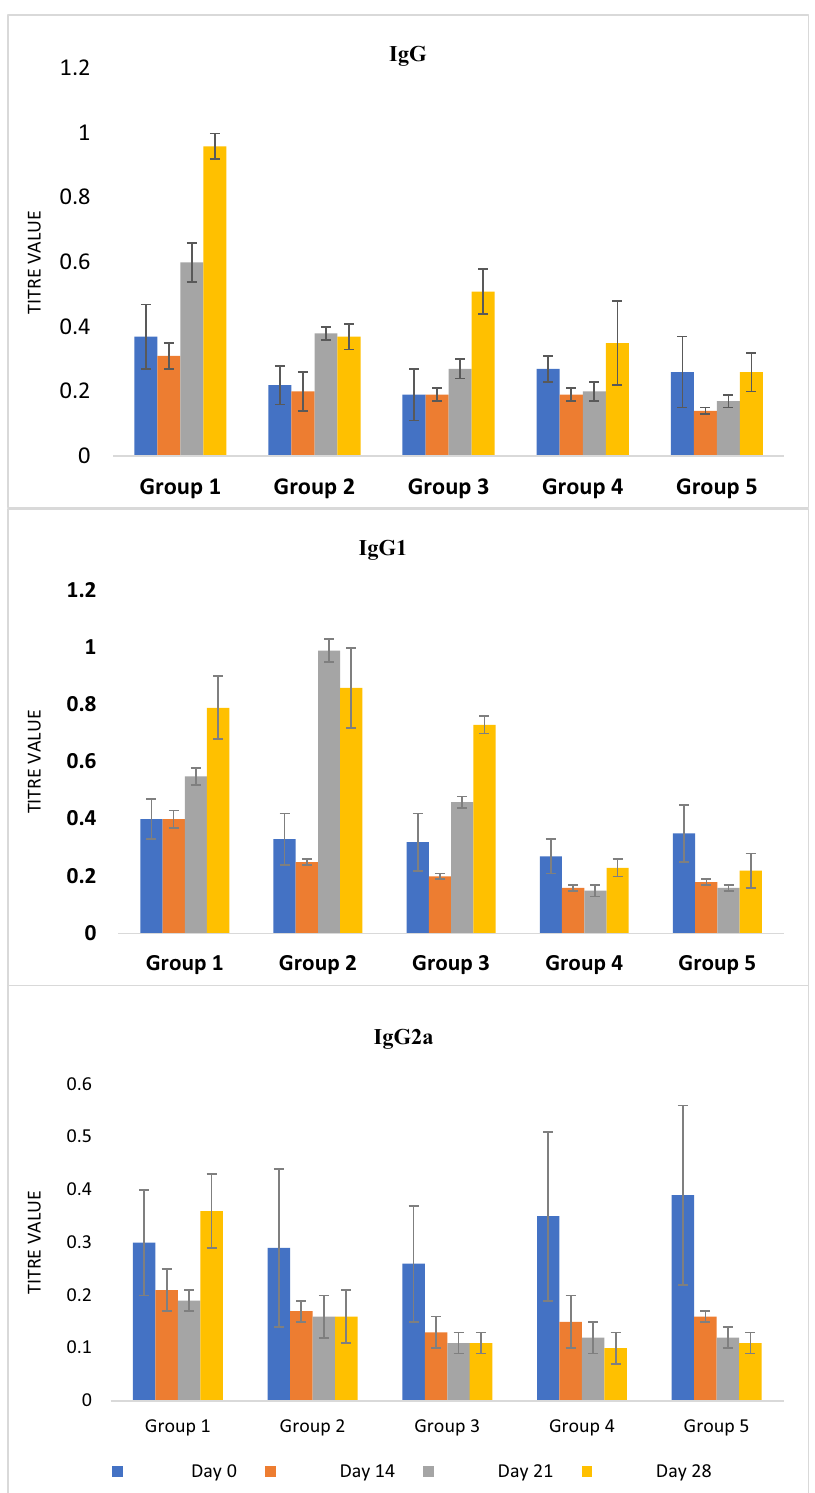
Fig. 3 Compound graph showing the IgG, IgG1 and IgG2a titer values from iELISA